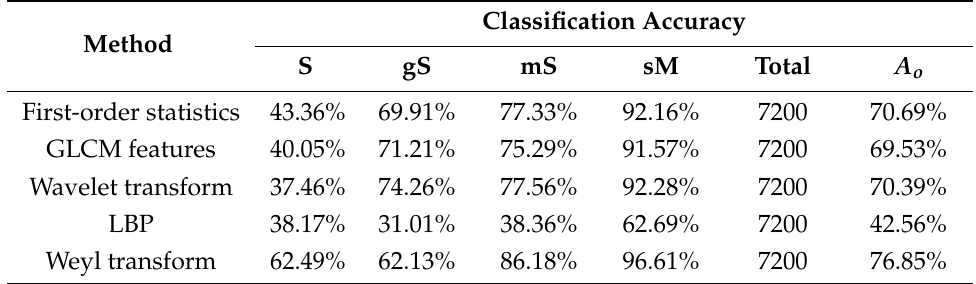
Table 7. Mean accuracy of the Random Forest model with different features by running 10